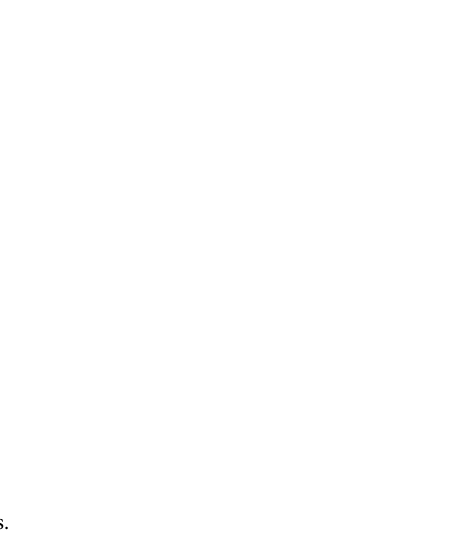
Table 2. Topographic, climatic, and housing characteristics.